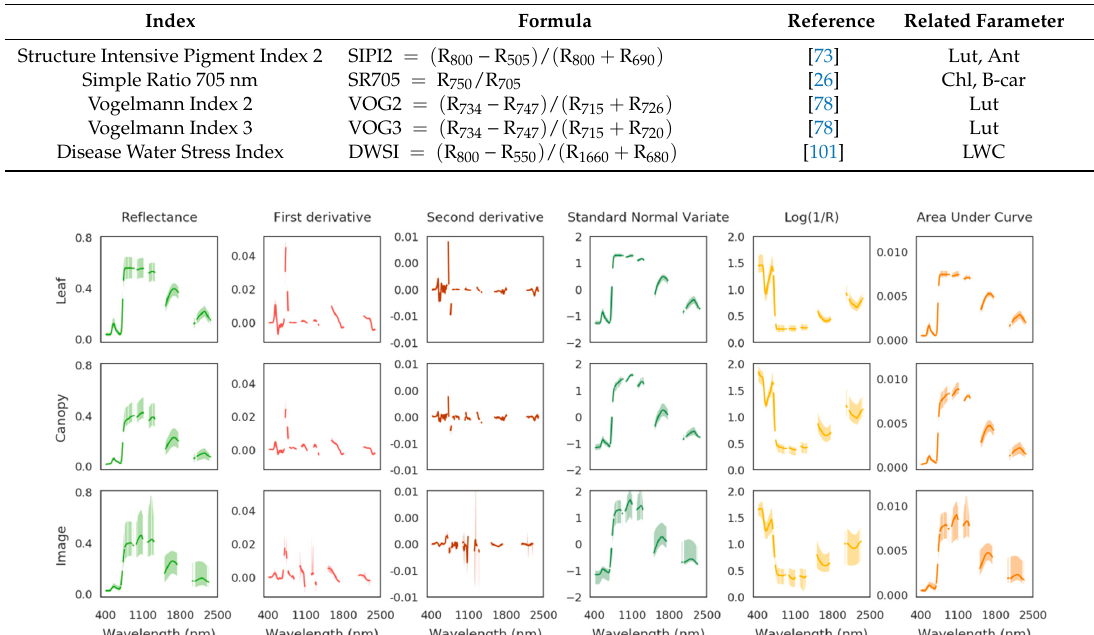
Figure A1. Original and transformed spectral signatures acquired in the brownfield at leaf and canopy scales and from the airborne image. The bold curve represents the median spectral signature and the colored area represents the (min:max) interval.